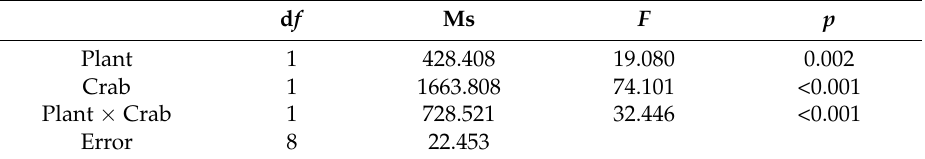
Table 1. Summary of two-way ANOVA results in the herbivory selection